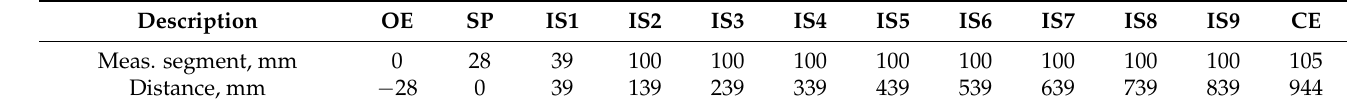
Table 2. Measuring segments and ion sensor locations.